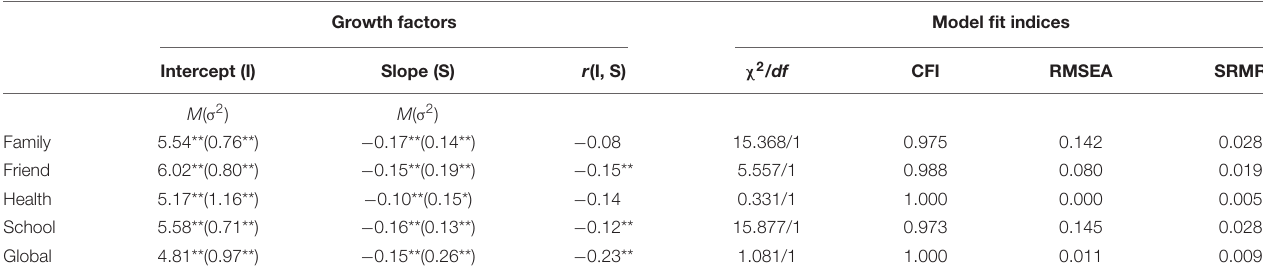
TABLE 3 | Latent growth models for life